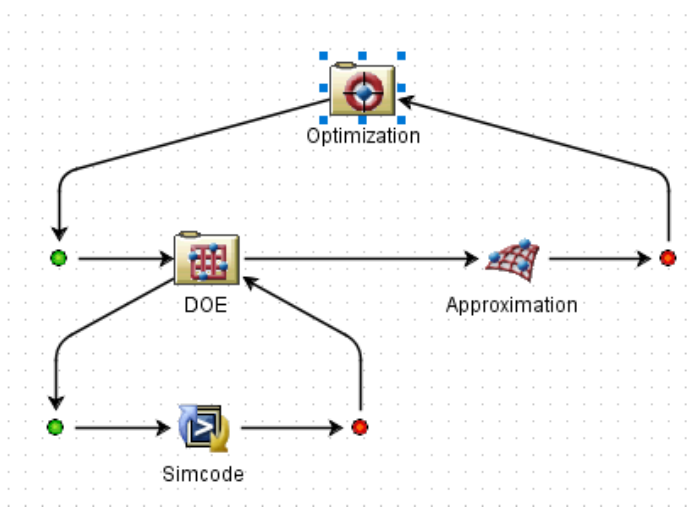
Table 3. Original and optimized optimization objective values .